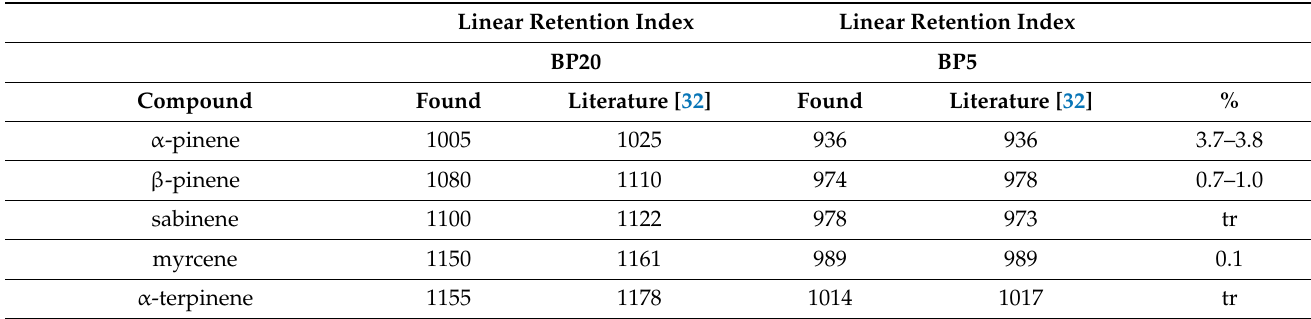
Table 2. Components identified in the leaf oil of Backhousia tetraptera.